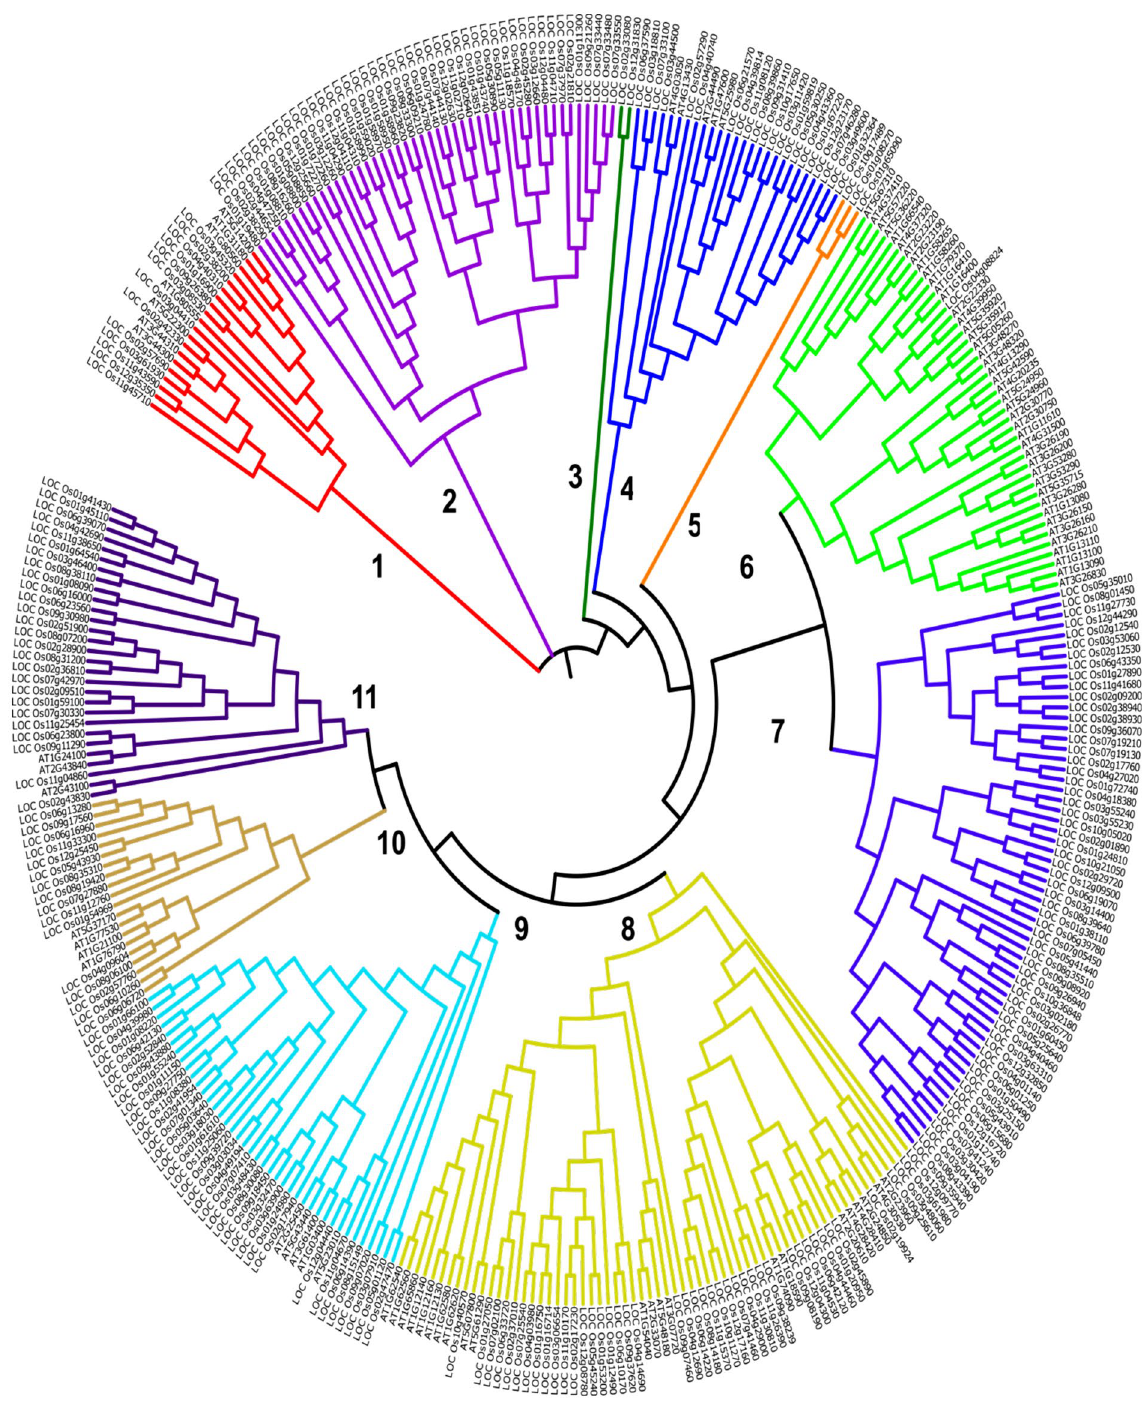
Figure 2. Phylogenetic analysis of collated sulfur-encoding biosynthetic genes in Arabidopsis thaliana and rice ( Oryza sativa ). The tree is constructed with MEGA